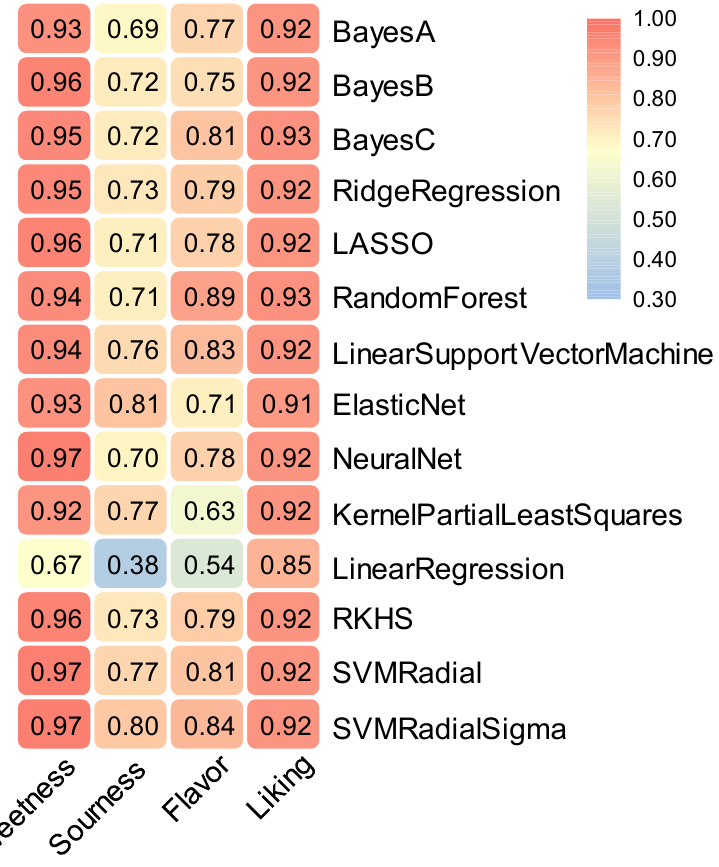
Figure 4. Model prediction of sensory characteristics.